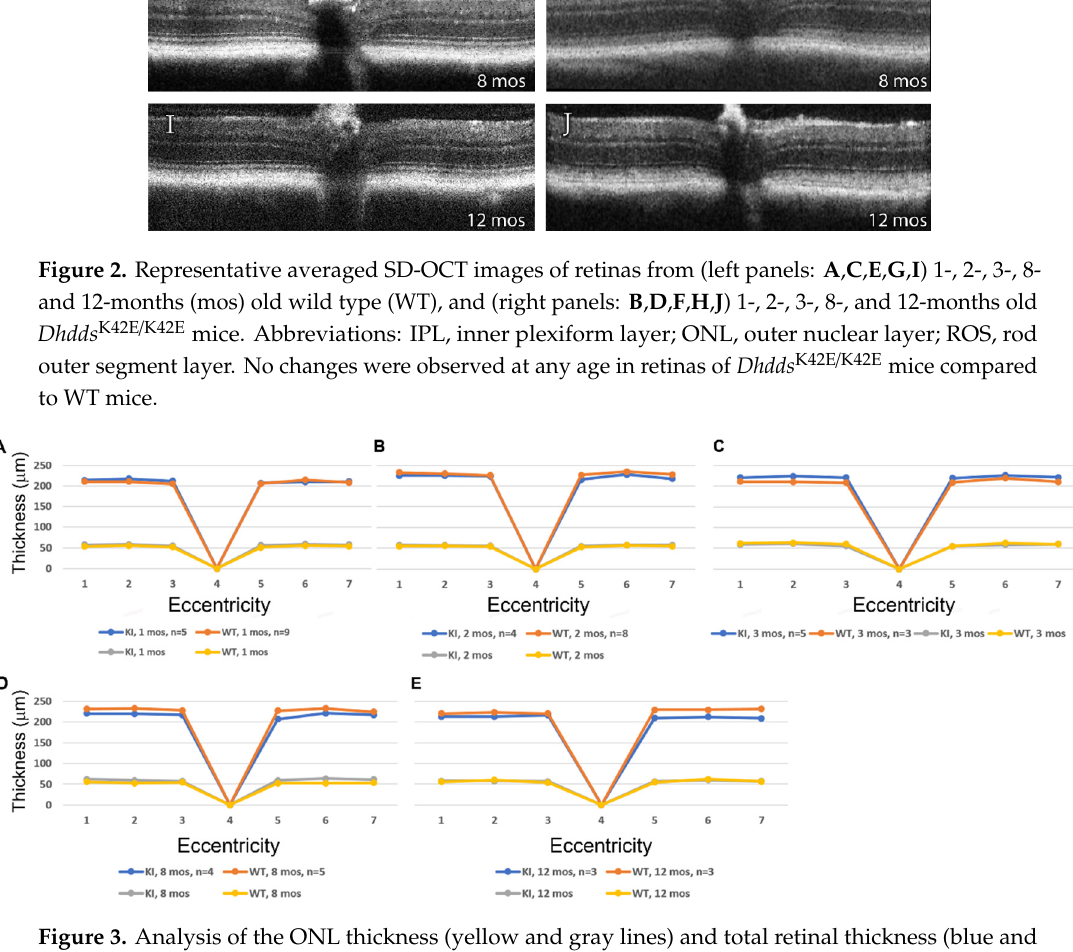
Figure 3. Analysis of the ONL thickness (yellow and gray lines) and total retinal thickness (blue and orange lines) in WT and Dhdds K42E / K42E mice ranging in age from PN 1 to 12 months. ( A ) 1 month, ( B ) 2 months, ( C ) 3 months, ( D ) 8 months, ( E ) 12 months. Outer nuclear layer (ONL) thickness and total retina thickness measurements (in microns), as a function of genotype and distance from the optic nerve head (ONH) along the vertical meridian in both the inferior and superior hemispheres. Genotypes: WT and Dhdds K42E / K42E mice. No significant di ff erences were observed between the